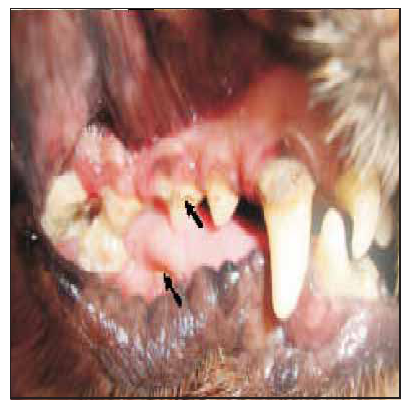
Figure-4: Periodontitis (severe) ulce- ration with excessive gingival recession